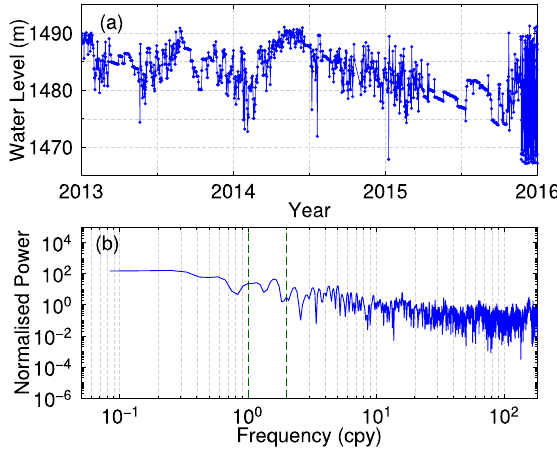
Figure 9. Water level time series ( a ) and the corresponding power spectra ( b ).